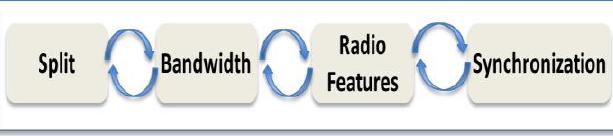
Figure 5. Illustration of the impact of functional splits over